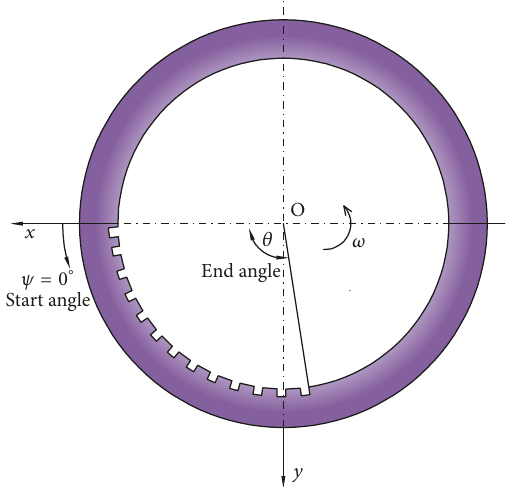
Figure 2: Partially textured journal bearing.